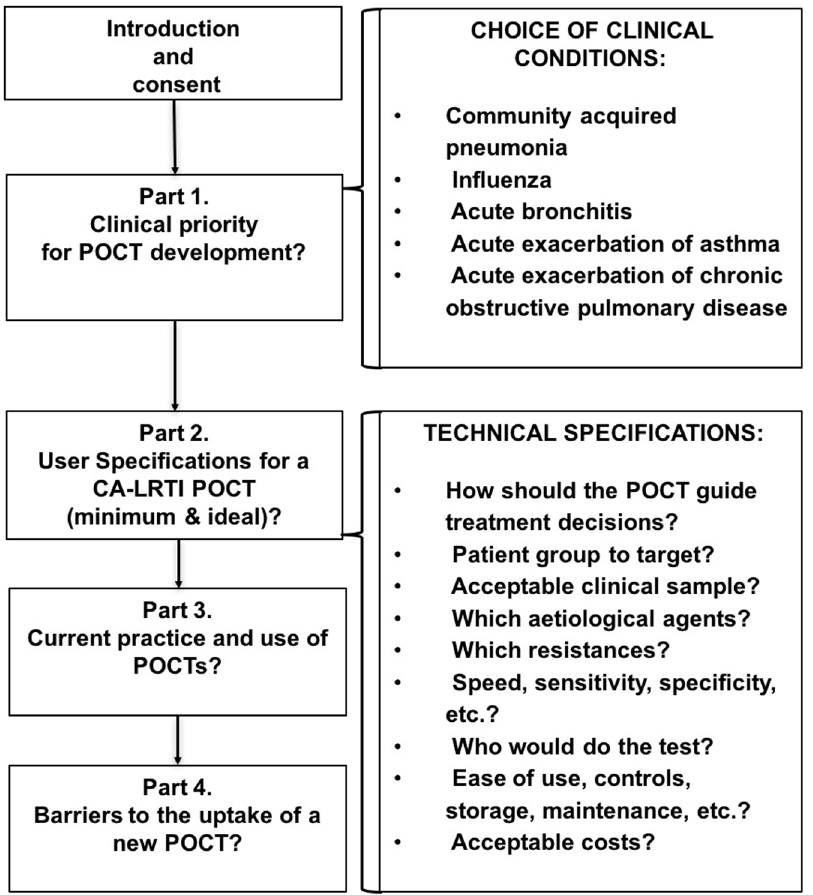
Fig 1. Survey to identify clinical need, minimum and ideal user requirements and perceived barriers for a new CA-LRTI POCT.